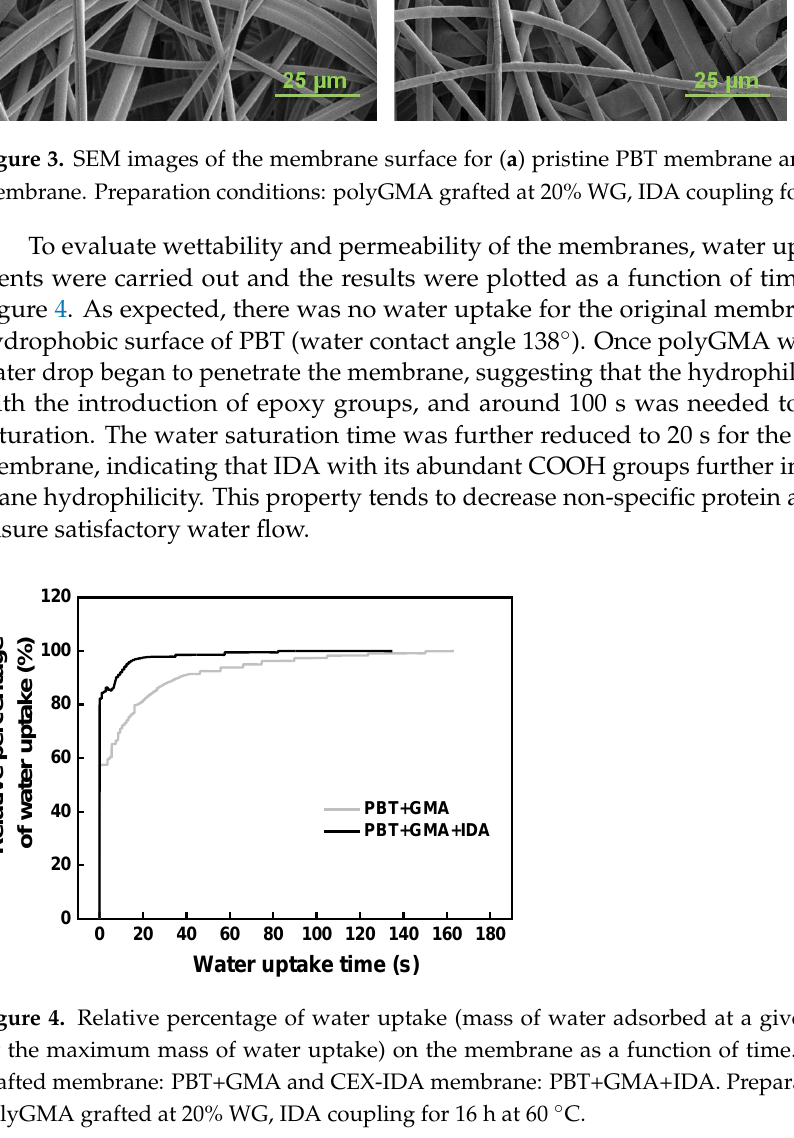
grafted membrane: PBT+GMA and CEX-IDA membrane: PBT+GMA+IDA. Preparation conditions: polyGMA grafted at 20% WG, IDA coupling for 16 h at 60 °C.